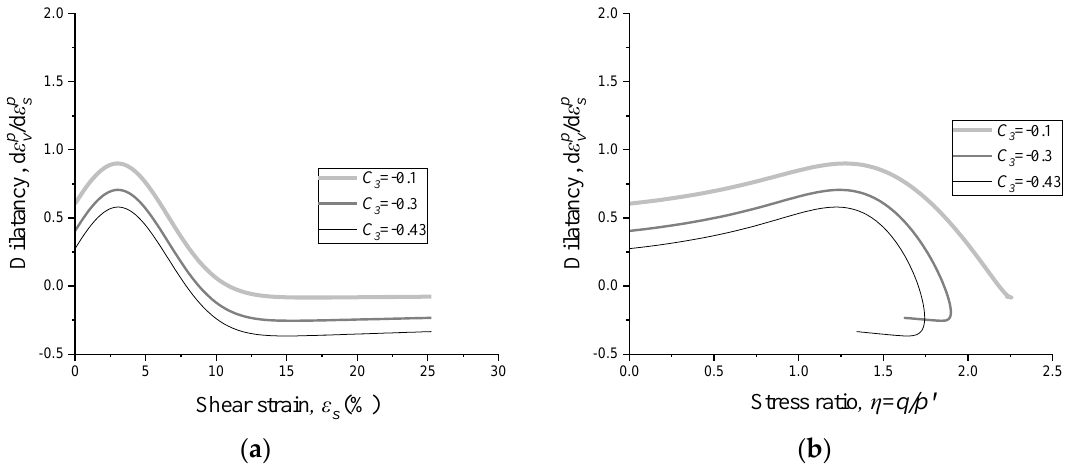
C increases, the 3